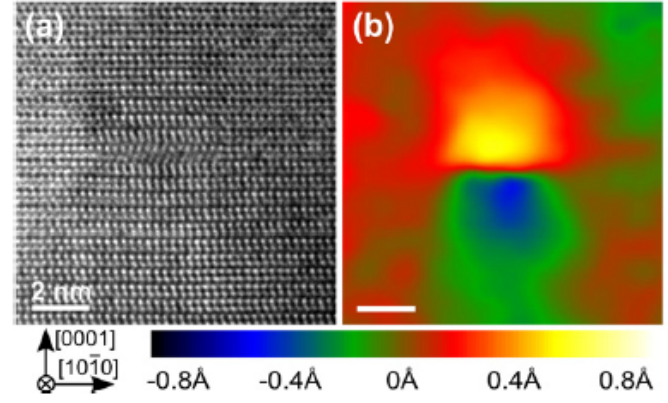
Figure 15. Identified GdN nanoplatelet in Ga 1 − x Gd x N from: ( a ) HRTEM and ( b ) displacement-field mapping along the [0001] direction. Reproduced with permission from Reference